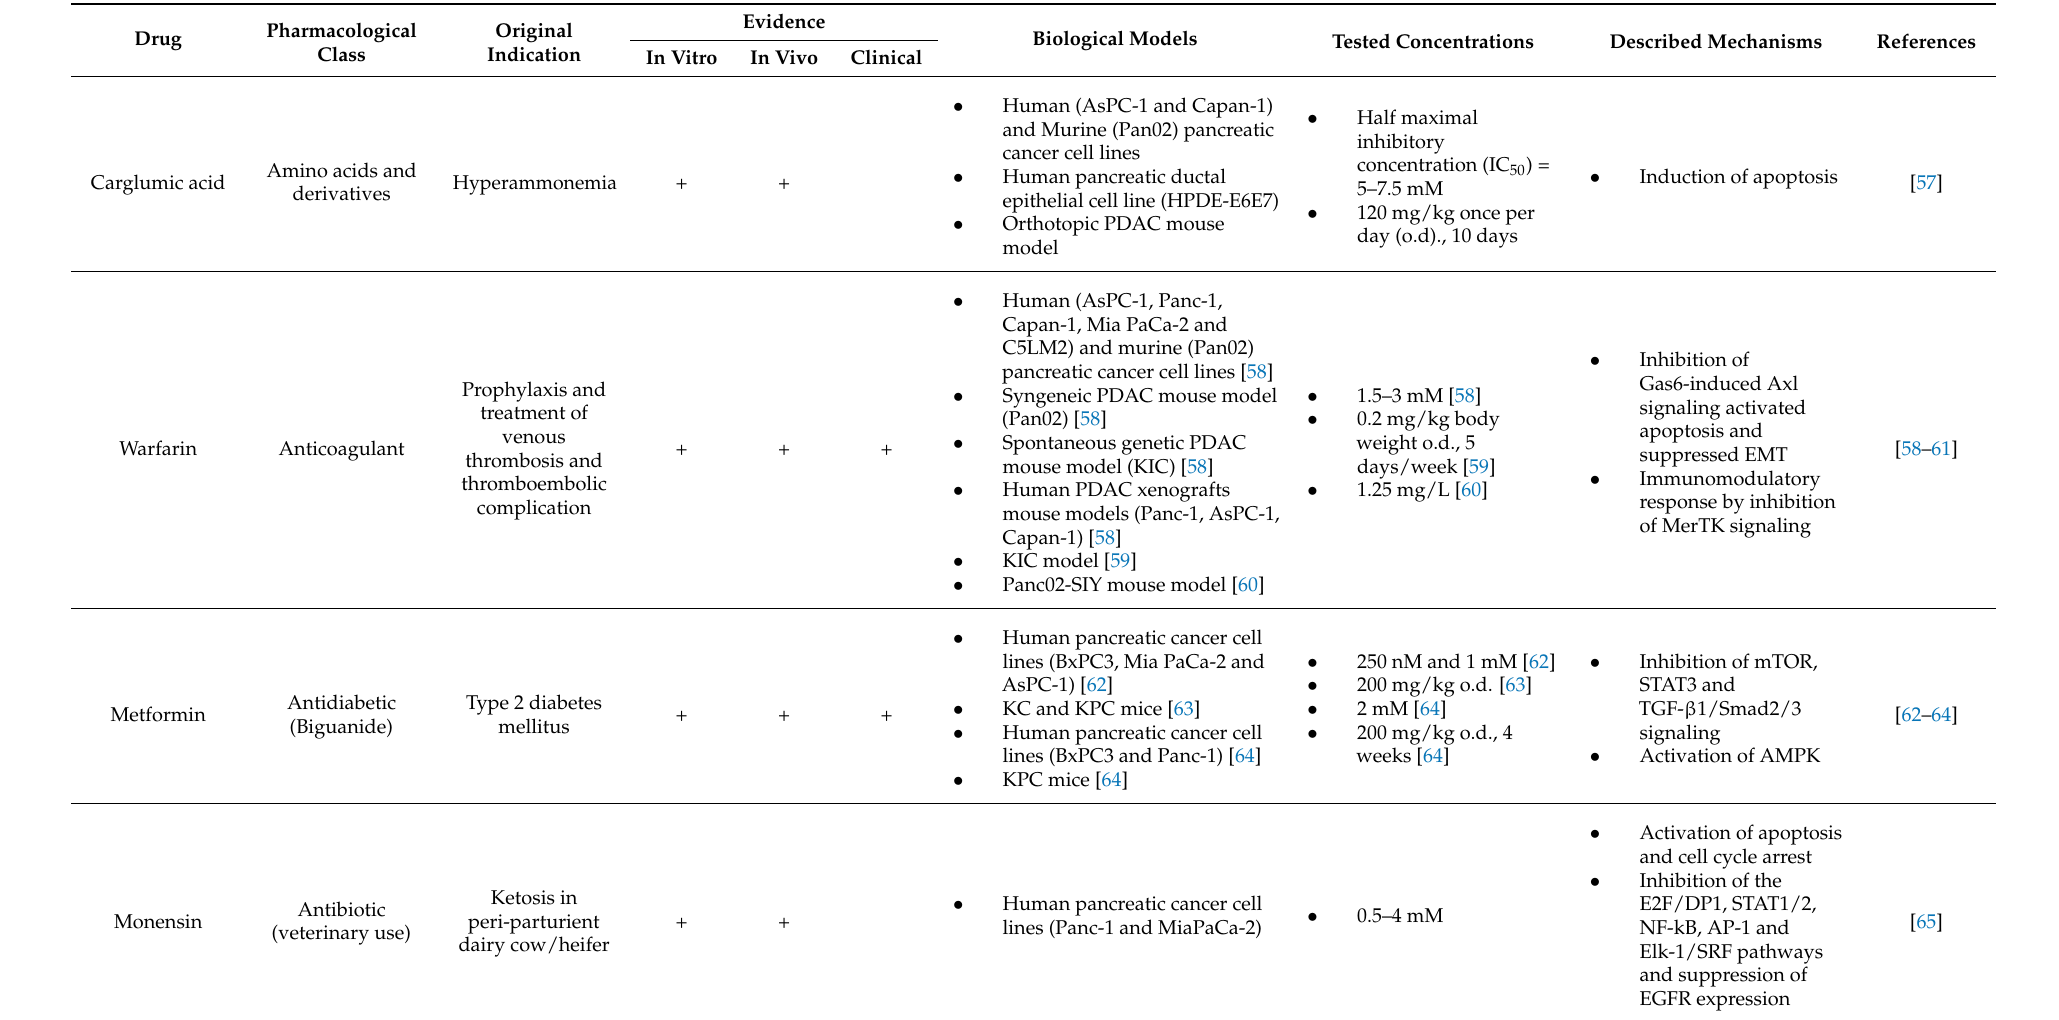
Table 2. Selected drug repurposing candidates for treatment of